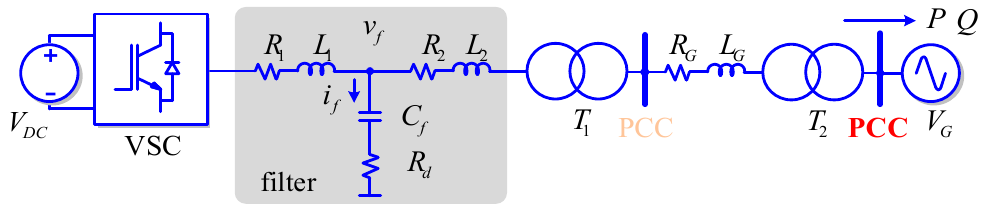
Figure 1. Overview of investigated system configurations.